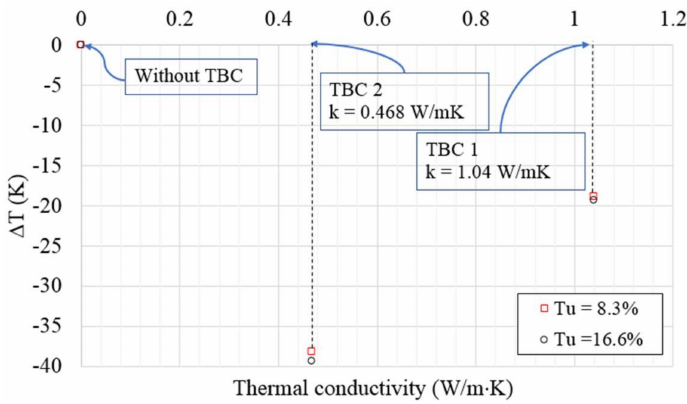
Figure 17. Reductions of average vane temperature at Tu = 8.3% and